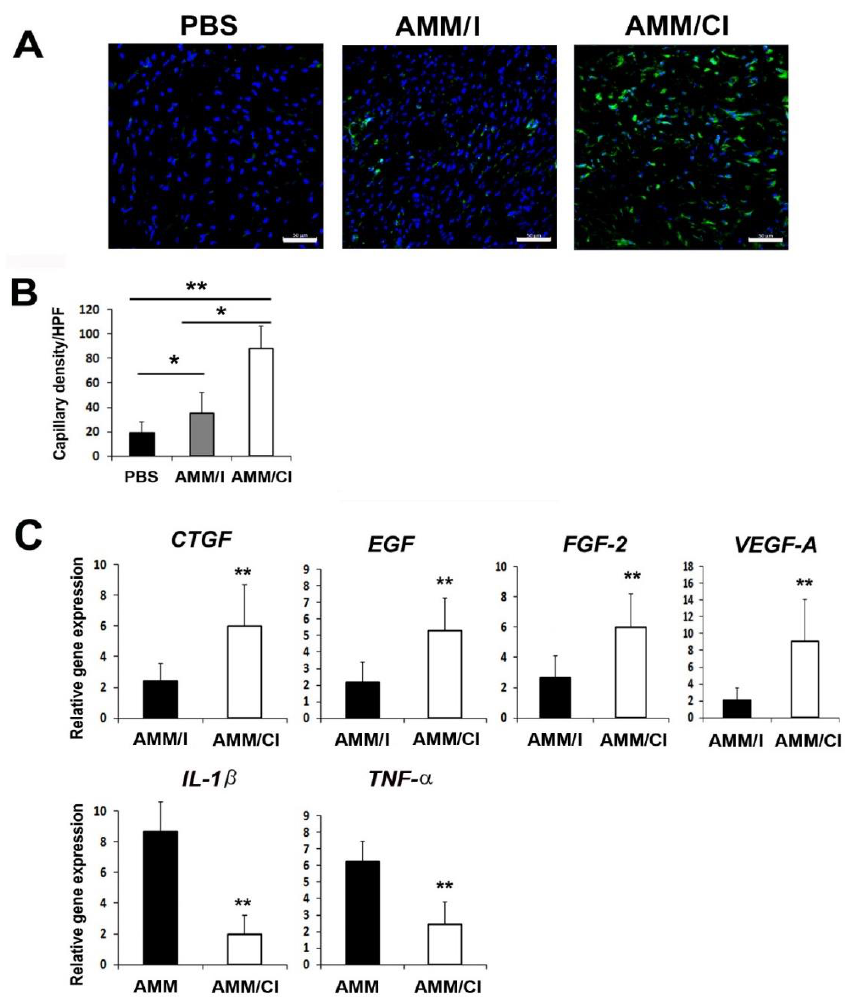
Figure 5. AMM/CI transplantation enhanced the capillary density and expression of angiogenic factors in wound areas. ( A ) Representative photographs of ILB4 (green), which is an endothelial cell marker, in the skin wounds at 10 days after cell injection. Nuclear (DAPI) staining is blue. Bars = 50 μ m. ( B ) Quantification of ILB4-positive cells in the skin wounds at 10 days after cell transplantation. * p < 0.05, ** p < 0.01, n = 7 per group. ( C ) Analysis of levels of angiogenic and inflammation gene expression in wound tissues 5 days after cell injection. Various angiogenic and inflammation gene expression levels were measured by qRT-PCR. ** p < 0.01, n = 7 per group.